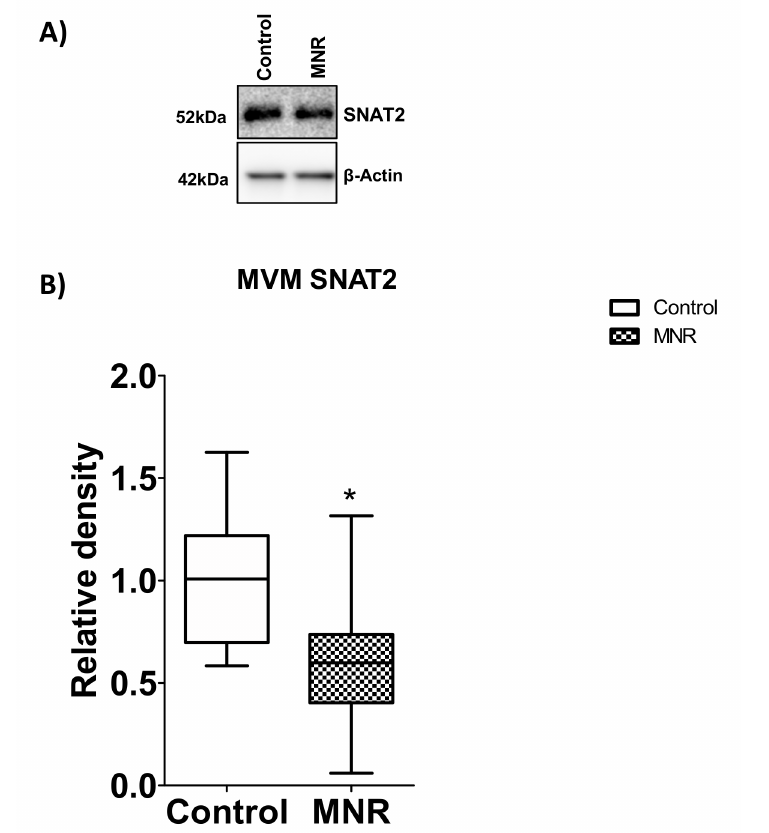
Figure 9. MVM SNAT2 protein expression at GD 140. ( A ) Western blot analysis of SNAT2 (system A amino acid transporter isoforms) expression in MVM isolated from control (C) and MNR (M) baboons. ( B ) The histogram shows protein expression data of MVM SNAT2. An equal amount of protein loading was performed. After normalization of MVM SNAT2 expression to loading control ( β -actin), the average density of the control sample band was designated an arbitrary value of 1. Values are represented as Medians ± IQR. * p < 0.05, Mann–Whitney test ( n = 8/each group). KS normality test p -value: MVM SNAT2 (Control, p > 0.10; MNR, p > 0.10; passed normality). 3.8. Protein Expression of TAUT and GLUT1 Transporter Isoforms in MVM at GD 140 The MVM protein expression of the taurine transporter (TAUT) and glucose trans- porter (GLUT1) were determined in control and MNR baboons (Figure 10). The TAUT and GLUT1 protein expression in the MVM was not different between the control and MNR groups (TAUT, n = 9/each group, p = 0.78; GLUT1, n = 8/each group). Significant changes in the fetal and placental weights, MVM and BM system A/L amino acid transport activity and isoform expression, maternal, fetal amino acid concentra- tion, and in vivo transplacental amnio acid transport activity in MNR baboons as compared to control at GD 120 [34], GD 140 (current study) and GD 165 [11,38] are summarized